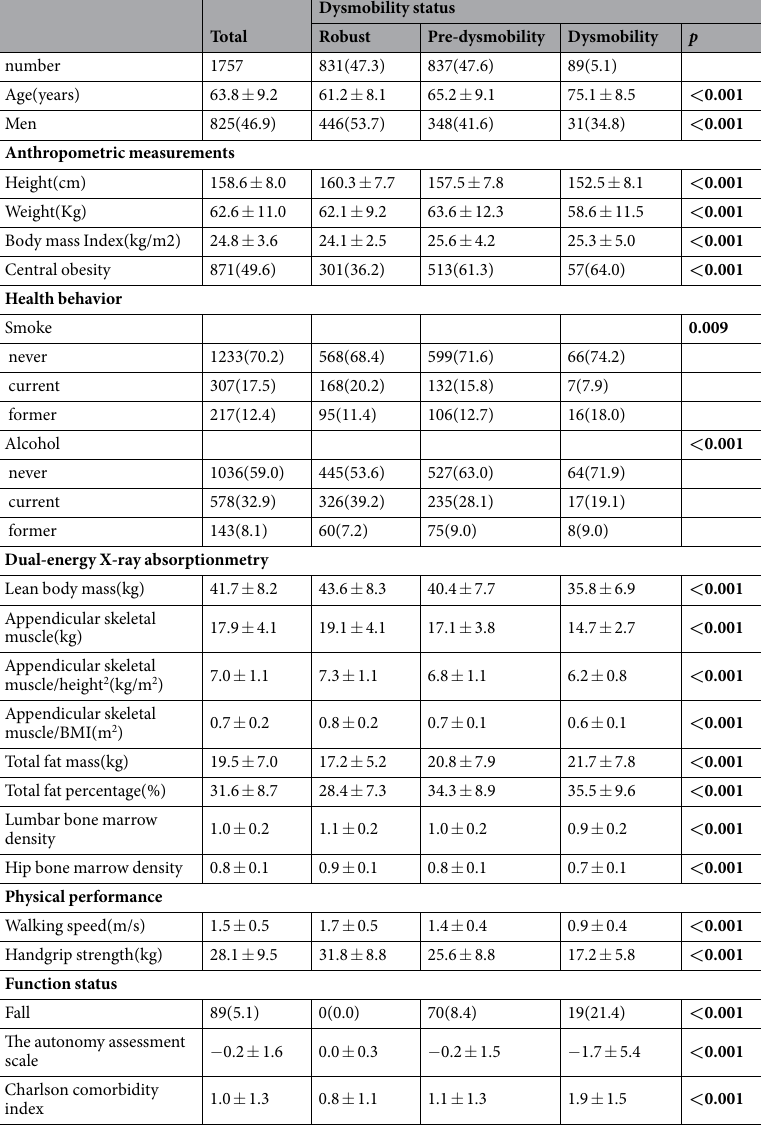
Table 1. Characteristics of participants of the I-Lan Longitudinal Aging Study. Numerical variables were expressed as mean ± standard deviation, categorized variables were expressed as